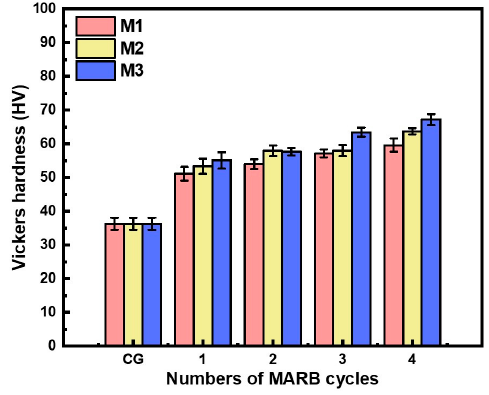
Figure 10. The hardness of M1, M2 and M3.